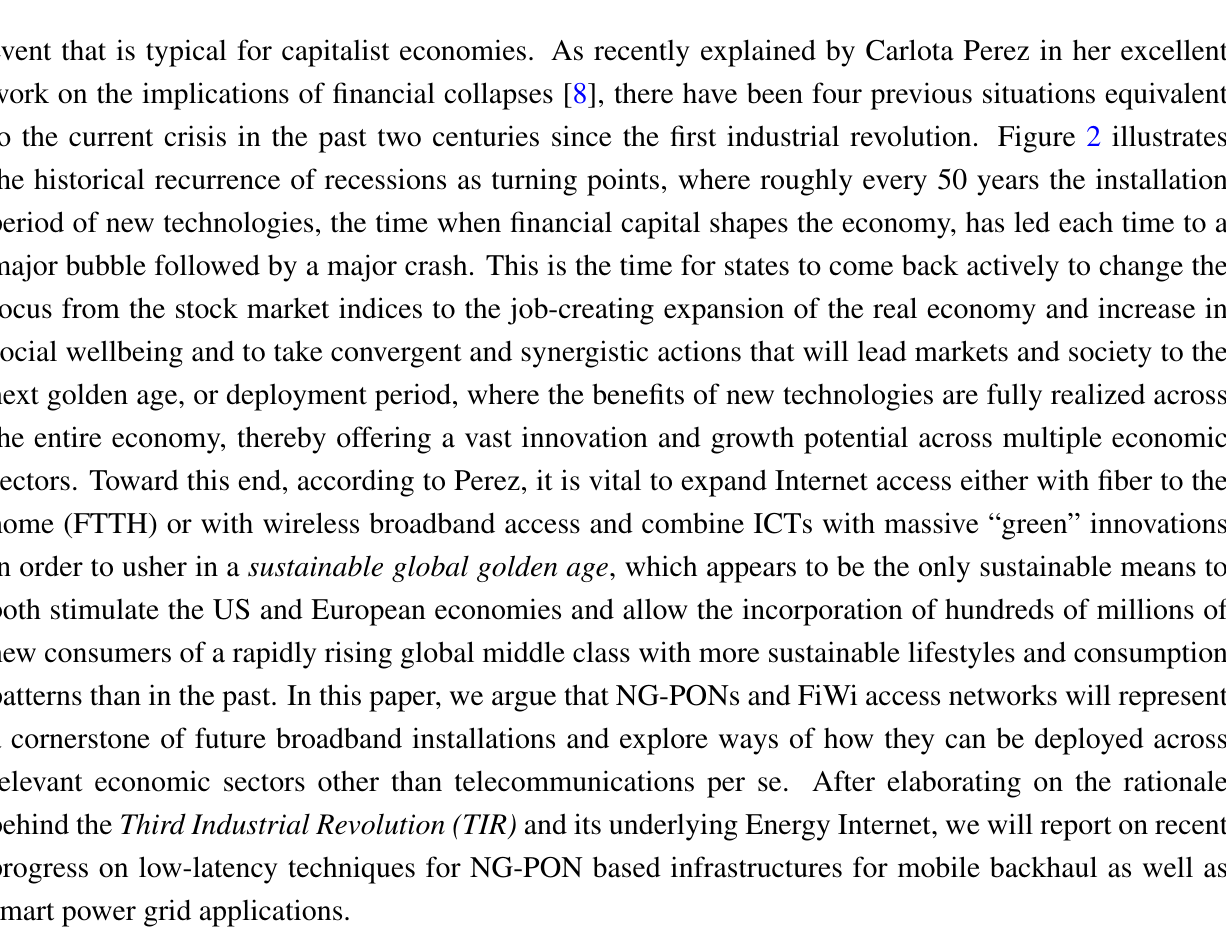
Historical recurrence of once-in-a-half-century bubble and golden age prosperities